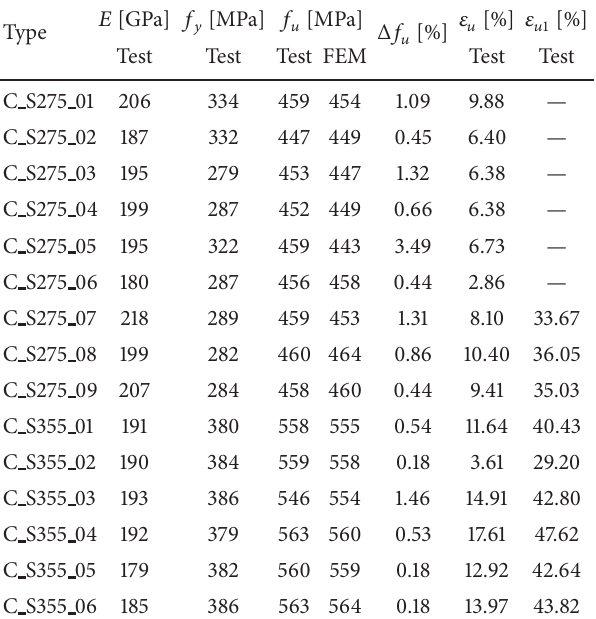
Table 5: Summary of experimental and numerical test results of steel specimens of grade S275 and